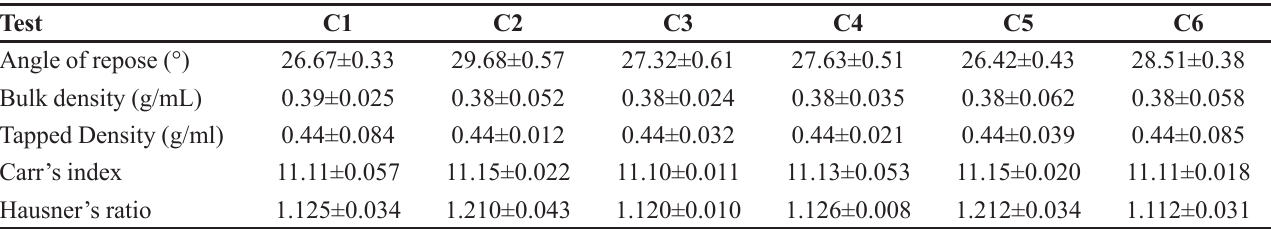
TABLE III - Evaluation of Flow properties of coated pellets with Kollicoat® Smartseal 30D D with triethyl citrate as plasticizer (Mean ± SD) (Three number each of C1- C6, n=3)